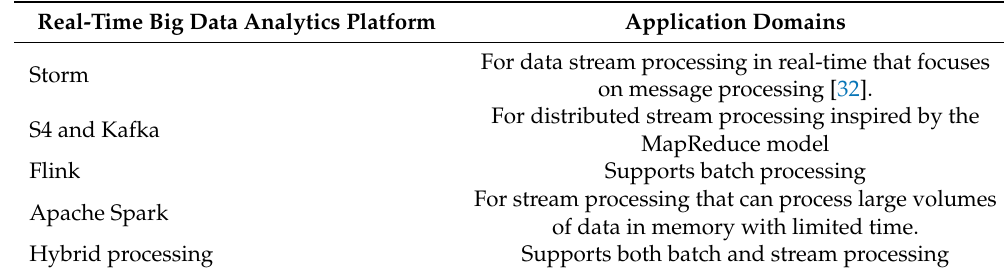
Table 1. Summary of big data